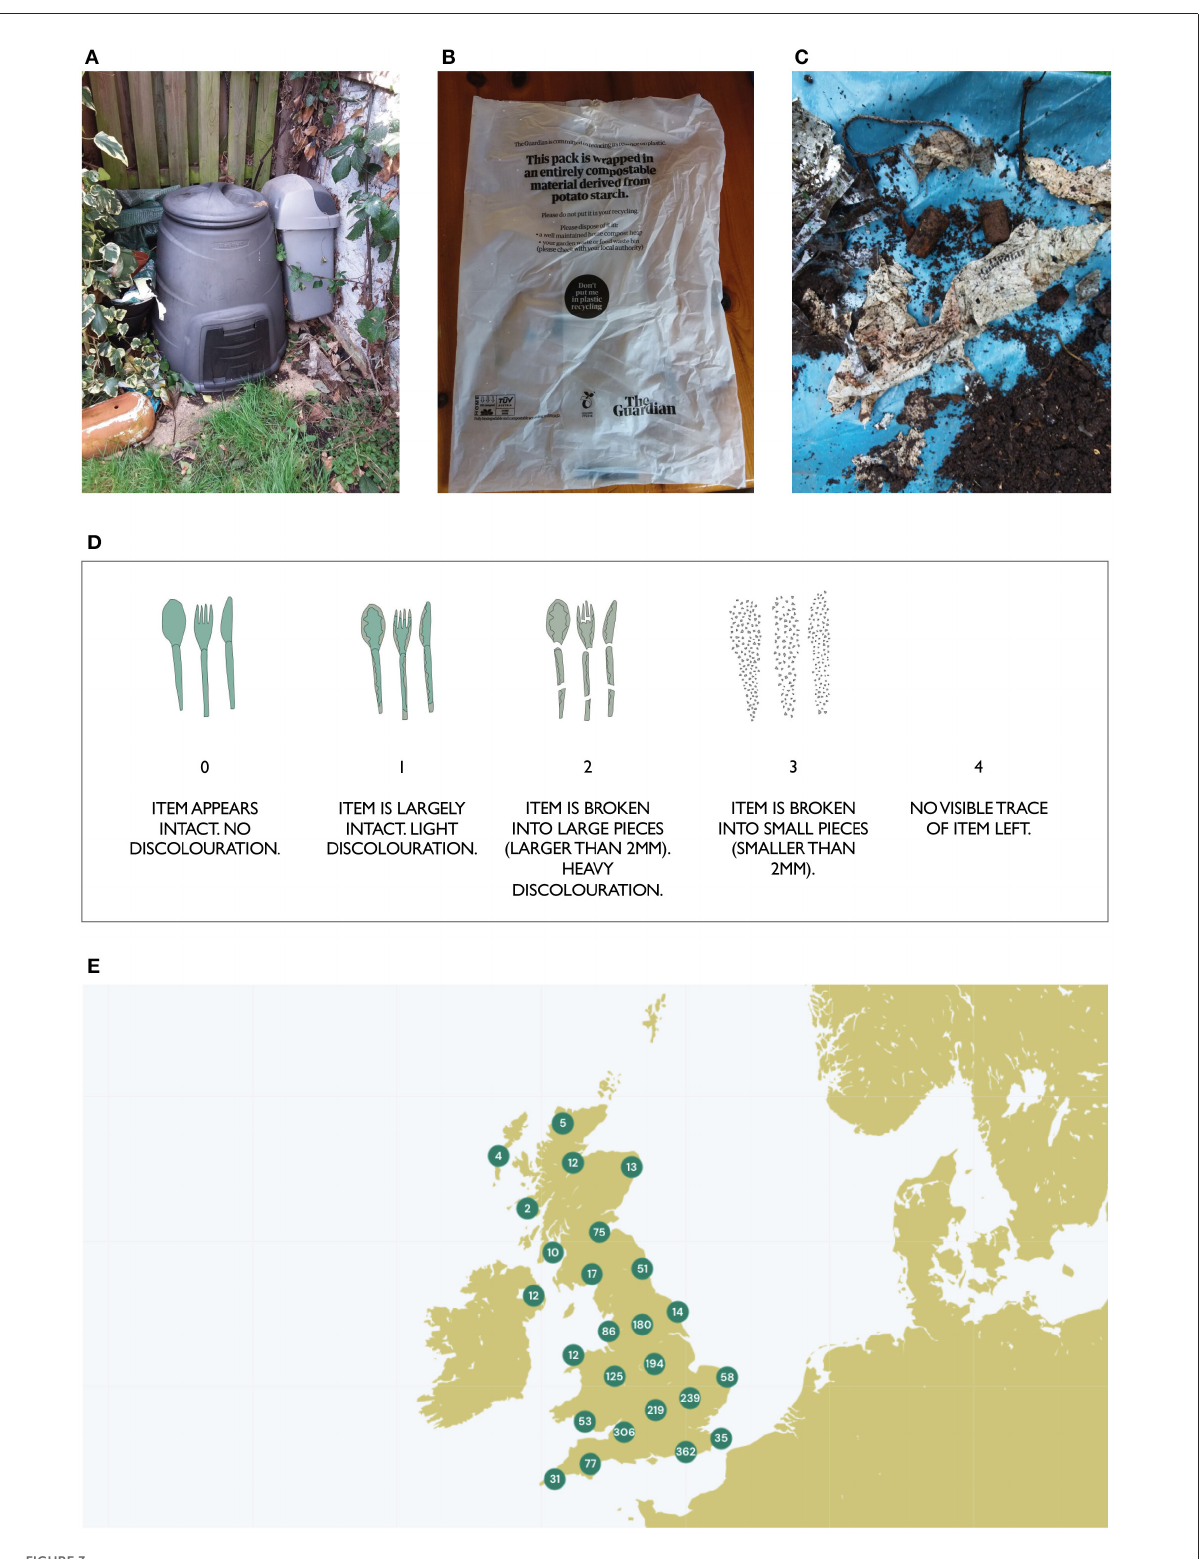
FIGURE3 Panel showing home compost experiment participant photo uploads showing composter type used (A) , item tested (B) and result (C) , scale of degradation used for results comparison (D) and UK home compost experiment participation map (E)